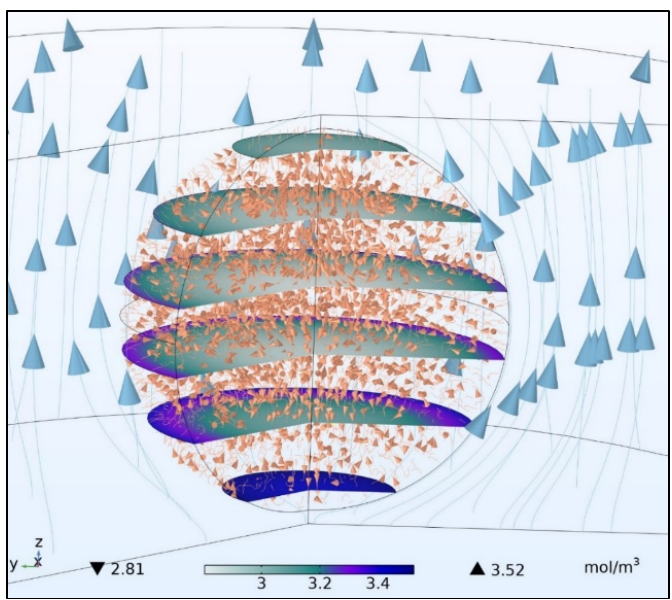
Figure 16. Velocity streamlines for reactant gas inside and outside the pellet (Experiment 3, X = 0.5) and the concentration slices of H 2 inside the pellet [mol/m 3 ]. and the concentration slices of H 2 inside the pellet [mol/m 3